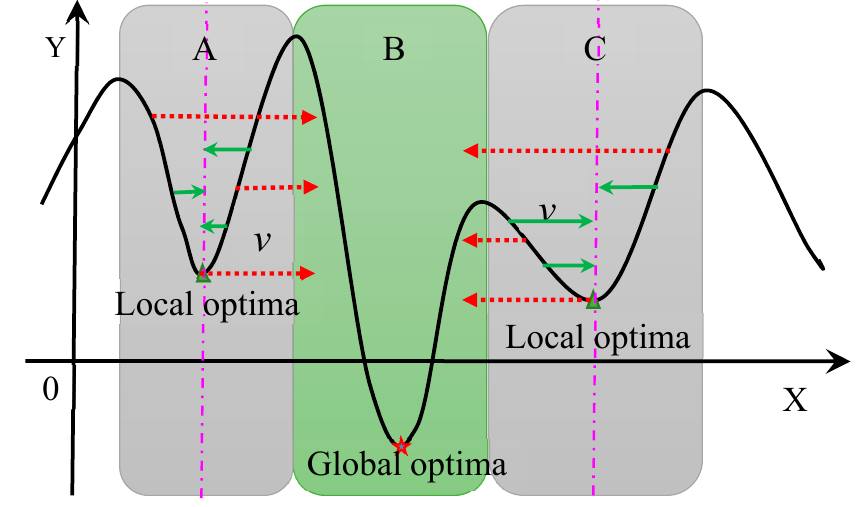
Figure 7. Schematic diagram of particles’ velocity.